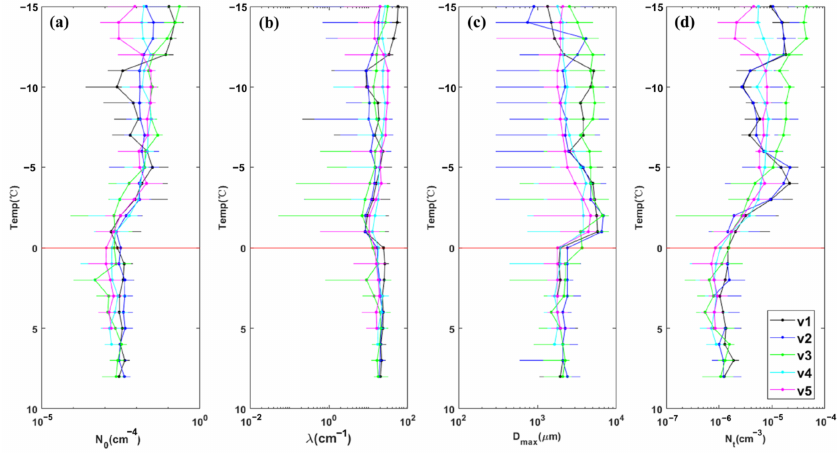
Figure 14. The parameters of 22 May 2017, ( a ) intercept ( N 0 ), ( b ) slope ( λ ), ( c ) the maximum particle size ( D max ), ( d ) the total particle concentration ( N t ). The red line is the 0 ◦ C layer.